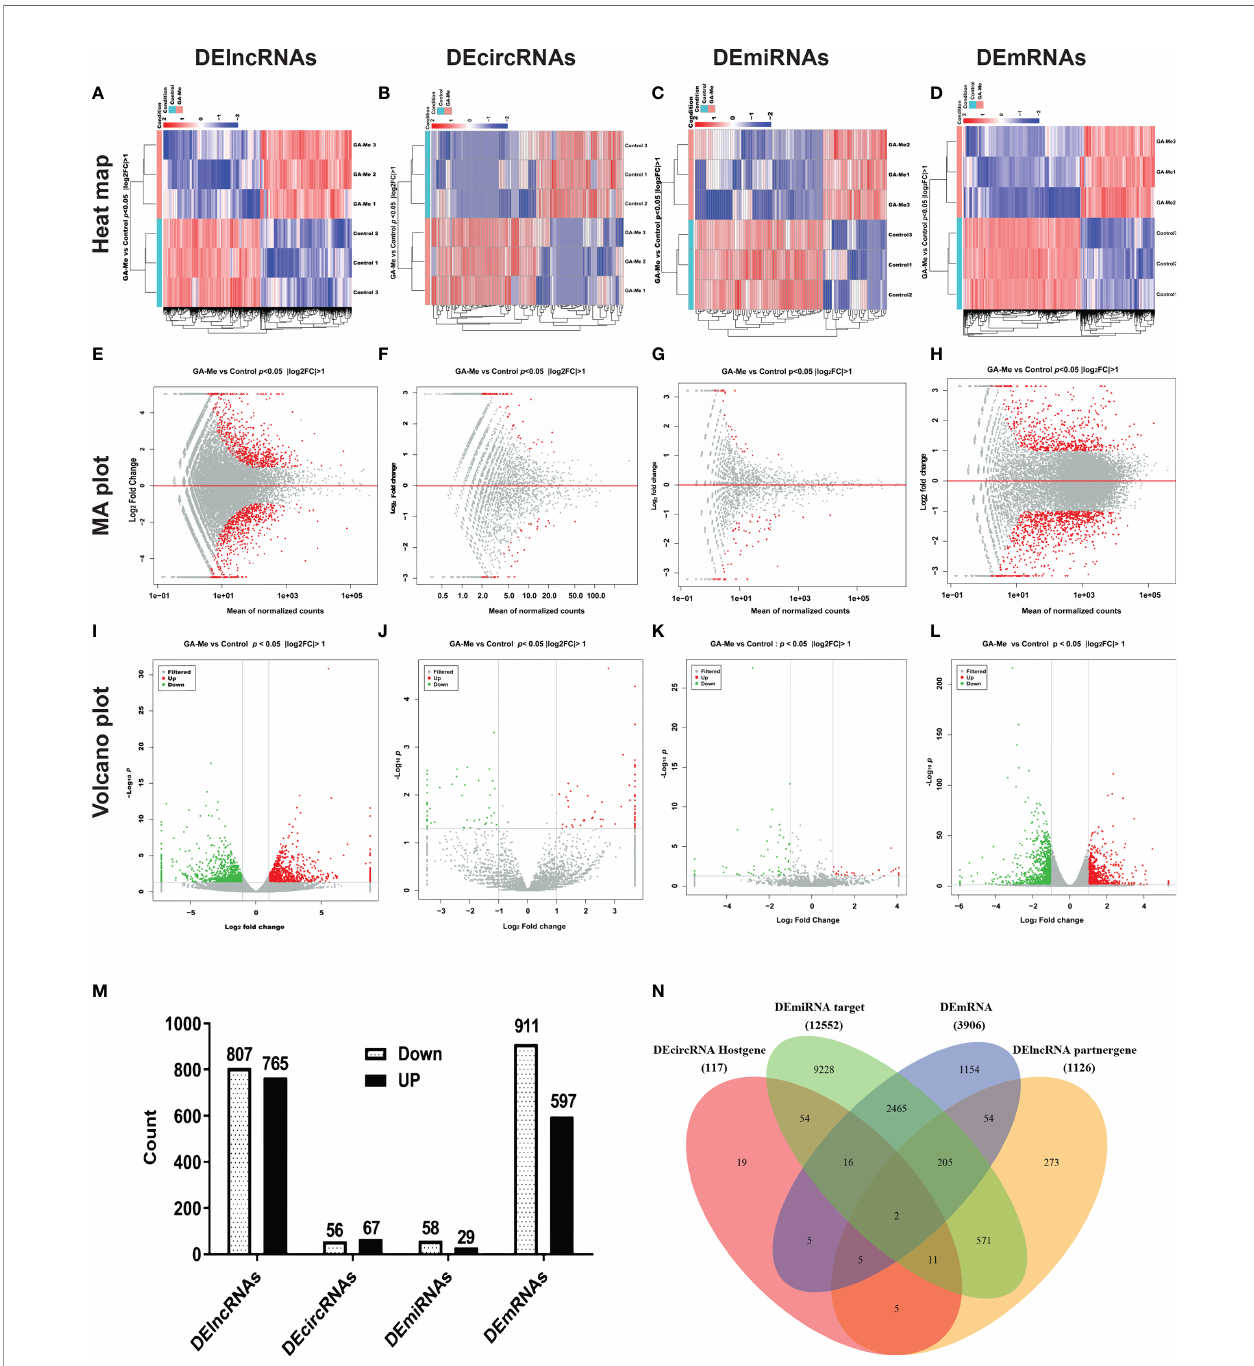
FIGURE 1 | RNA-Seq revealed distinct expression levels and patterns of lncRNAs, circRNAs, miRNAs, and mRNAs in untreated and GA-Me-treated HCT116 cells. (A – D) Unsupervised clustering analysis comparing the expression pro fi les of DElncRNAs, DEcircRNAs, DEmiRNAs, and DEmRNAs between untreated and GA-Me- treated HCT116 cells. (E – H) MA plot of DElncRNA, DEcircRNA, DEmiRNA, and DEmRNA expression pro fi les between untreated and GA-Me-treated HCT116 cells. (I – L) Volcano plot of DElncRNA, DEcircRNA, DEmiRNA, and DEmRNA expression pro fi les between untreated and GA-Me-treated HCT116 cells. Histogram showing the number of up- and downregulated ncRNAs and mRNAs (M) . Venn diagram showing the number of overlapping DEmRNAs, DElncRNA-target trans mRNAs, DEmiRNA-target mRNAs, and DEcircRNA-host genes. RNA-Seq revealed distinct expression patterns of lncRNAs, circRNAs, miRNAs, and mRNAs between untreated and GA-Me-treated HCT116 cells (N) . GA-Me 1, GA-Me 2, and GA-Me 3 represent the three groups of HCT116 cells treated with GA-Me. Control 1, Control 2, and Control 3 represent three groups of untreated HCT116